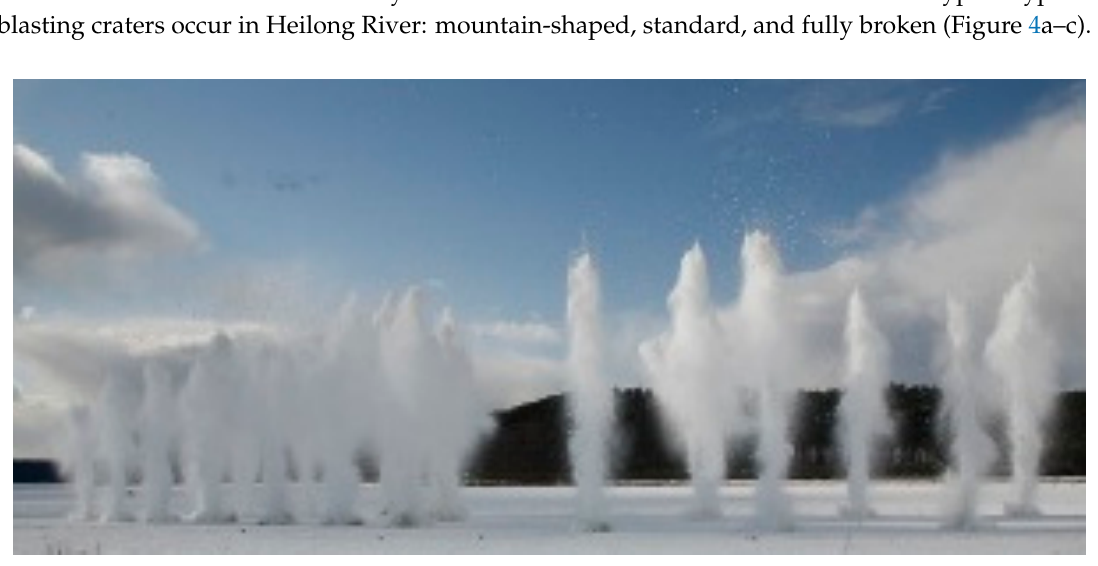
Figure 3. Example of ice cover blasting in the Mohe reach, Heilong